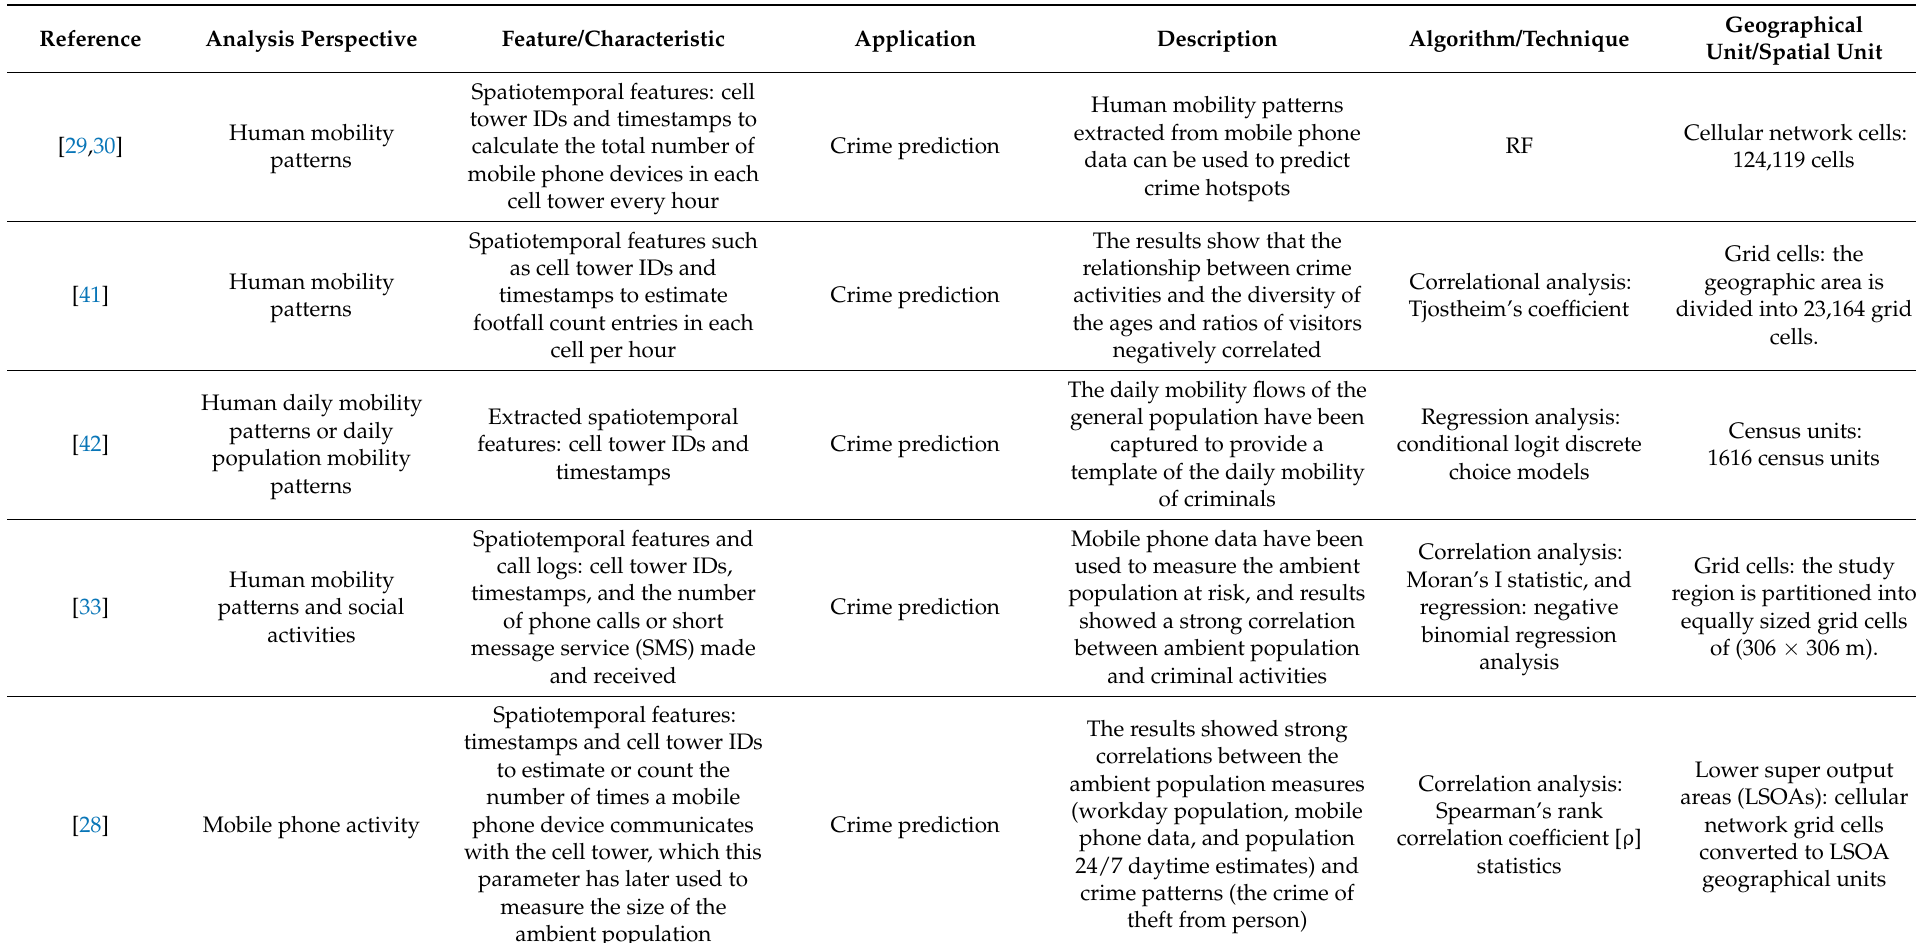
Table 2. List of applications, methods, and features used in criminology based on mobile phone